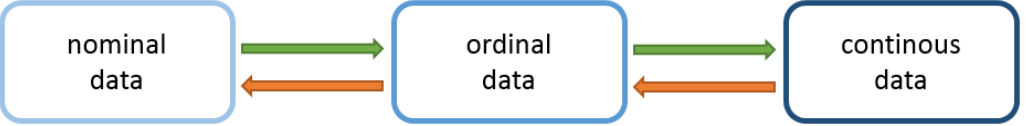
Figure 4. Changing the levels of measurement: arrows to the left mean a “downgrade” of the level of measurement, arrows to the right mean an “upgrade” (often artificial) of the level of measurement.